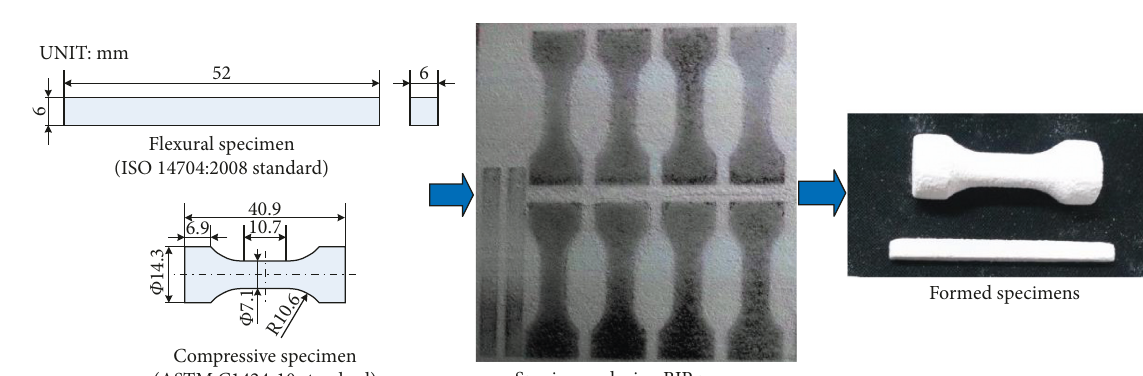
Figure 3: Two types of standard test specimens formed for each experiment